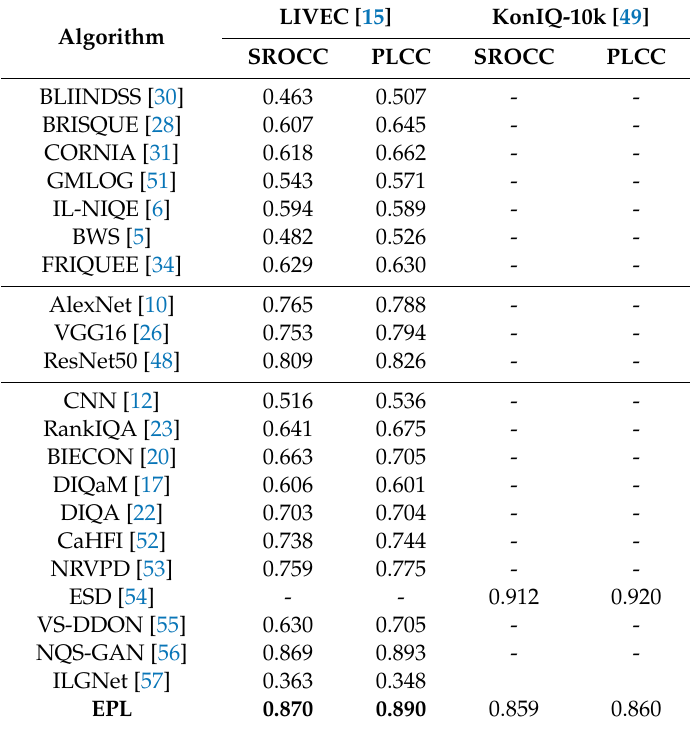
Table 7. Performance comparison between EPL and other